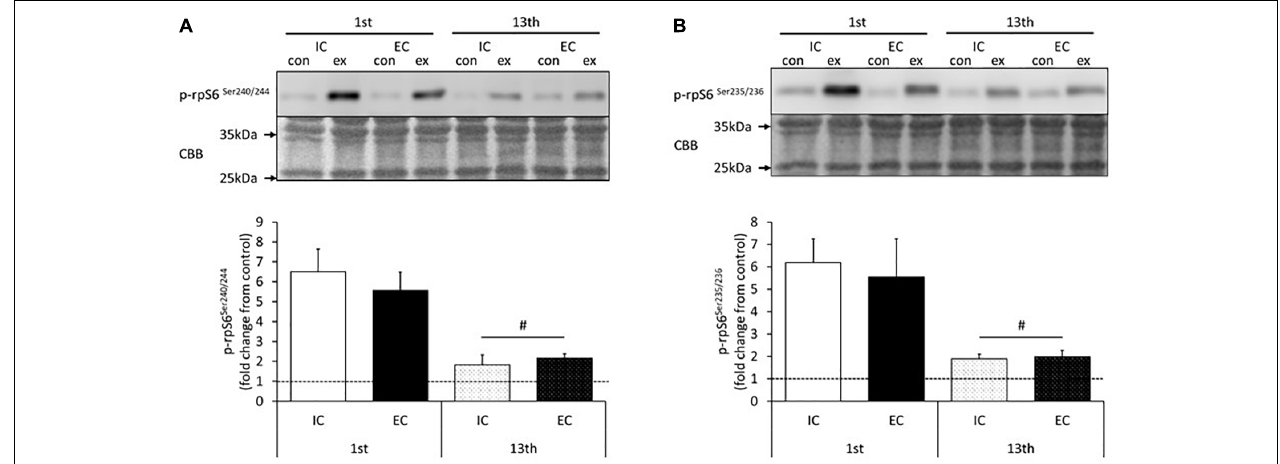
FIGURE 4 | Phosphorylation of ribosomal protein S6 on Ser240/244 (A) and Ser235/Ser236 (B) after the 1st and 13th bouts of exercise. Values are means ± SE. # Main effect of training ( p < 0.05).